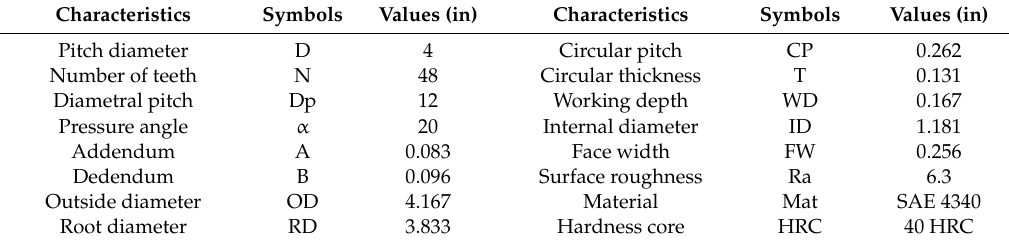
Table 3. Dimensional characteristics of the